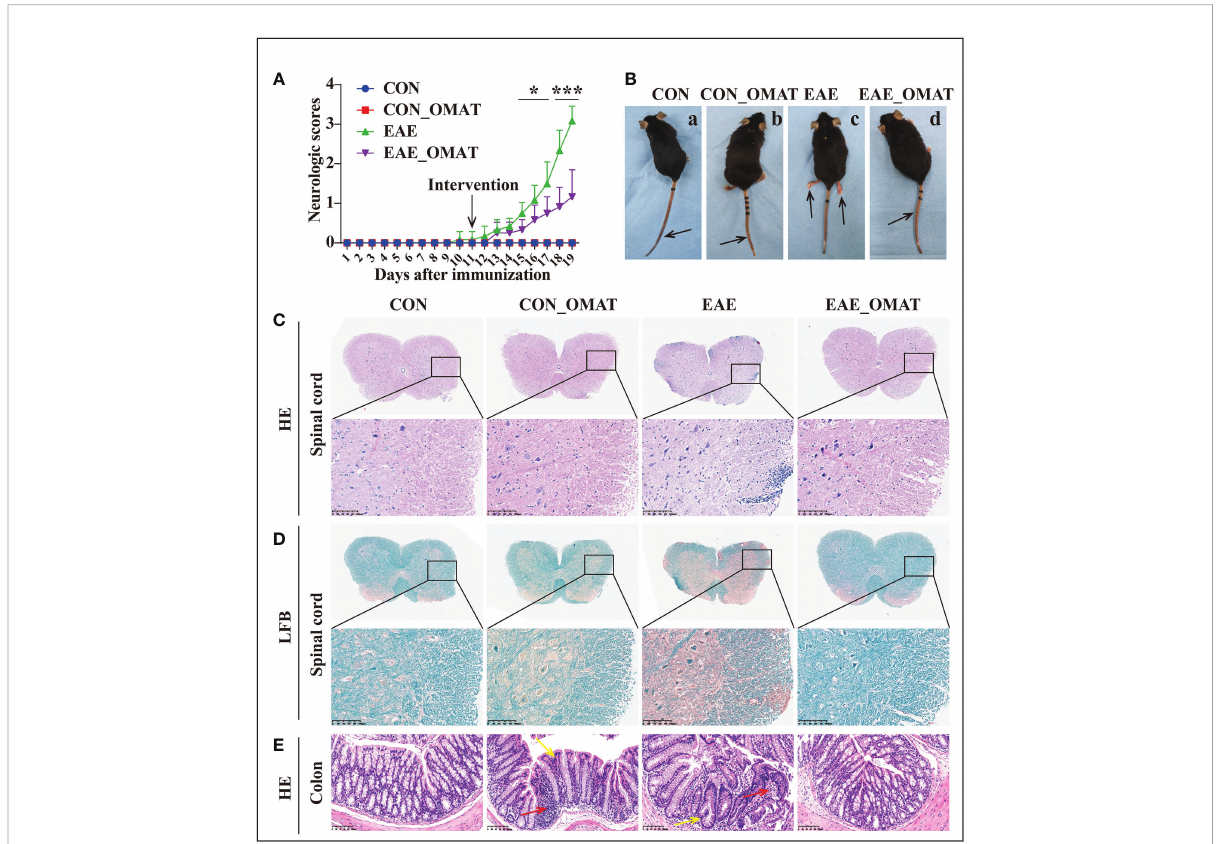
FIGURE 1 Results of the pathological and histological examination of the spinal cord and colon of the mice from the four groups (n = 6 in each group). (A) Clinical scores and (B) clinical phenotypes of mice from the different groups. The black arrow indicates the paralyzed area. a, CON group mice with no de fi cit; b, CON_EAE group mice with no de fi cit; c, EAE group mice showing paralysis of both hind limbs; d, EAE_OMAT group mice showing tail paralysis. (C, D) Representative images of the histology of the spinal cord were determined by HE (C) and LFB (D) staining. Original magni fi cation, 4X; the partial enlarged picture of each group was magni fi ed 20X. (E) Representative images of the histology of the colon determined by HE staining (20X). Red arrows indicate colon tissue in fi ltration by in fl ammatory cells, yellow arrows indicate the change in crypt structure. Data are expressed as the mean ± SD and statistical differences are represented by *, P < 0.05; ***, P < 0.001 based on Wilcoxon rank-sum